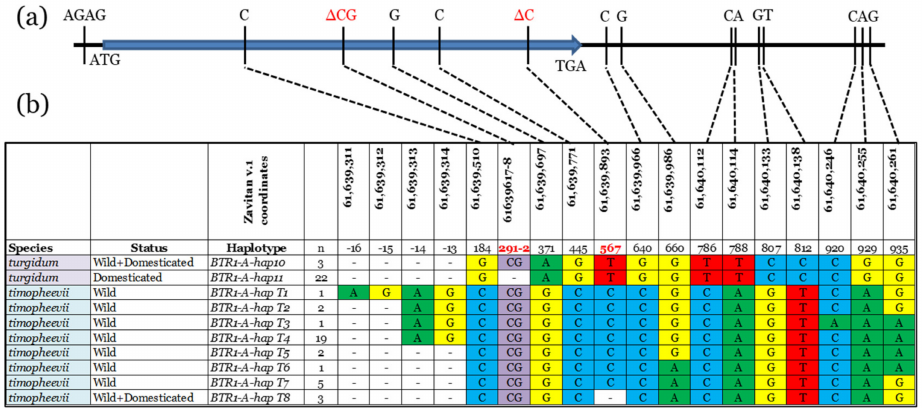
Figure 1. ( a ) Schematic showing the locations of the sequence polymorphisms used in the BTR1-A haplotype analysis. Highlighted in red font are two frameshift deletions in the BTR1-A coding sequence. ( b ) Among the materials included in this study, a total of 10 BTR1-A haplotypes were identified, two within the T. turgidum species and eight within the T. timopheevii species. In T. timopheevii , BTR1-A-hapT7 is the closest wild haplotype to the domesticated haplotype BTR1-A-hap T8 , differing only in the 1 bp frameshift deletion at position 567. The “Status” column refers to the historical domestication status according to the relevant seed source. Colors help to detect the